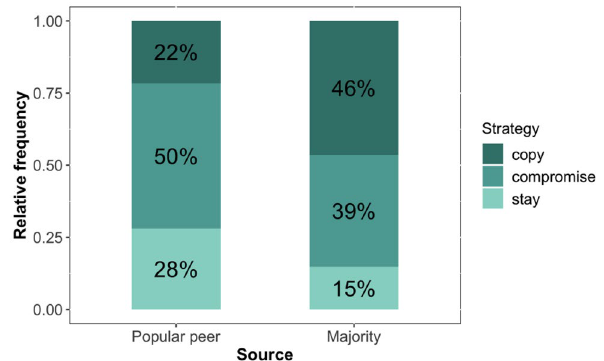
Figure 4. Participants’ norm updating strategies. Stacked bars show the distribution of norm updating strategies used by participants when exposed to normative information. The way they applied these strategies differed considerably when observing information provided by a popular peer and the majority from their social